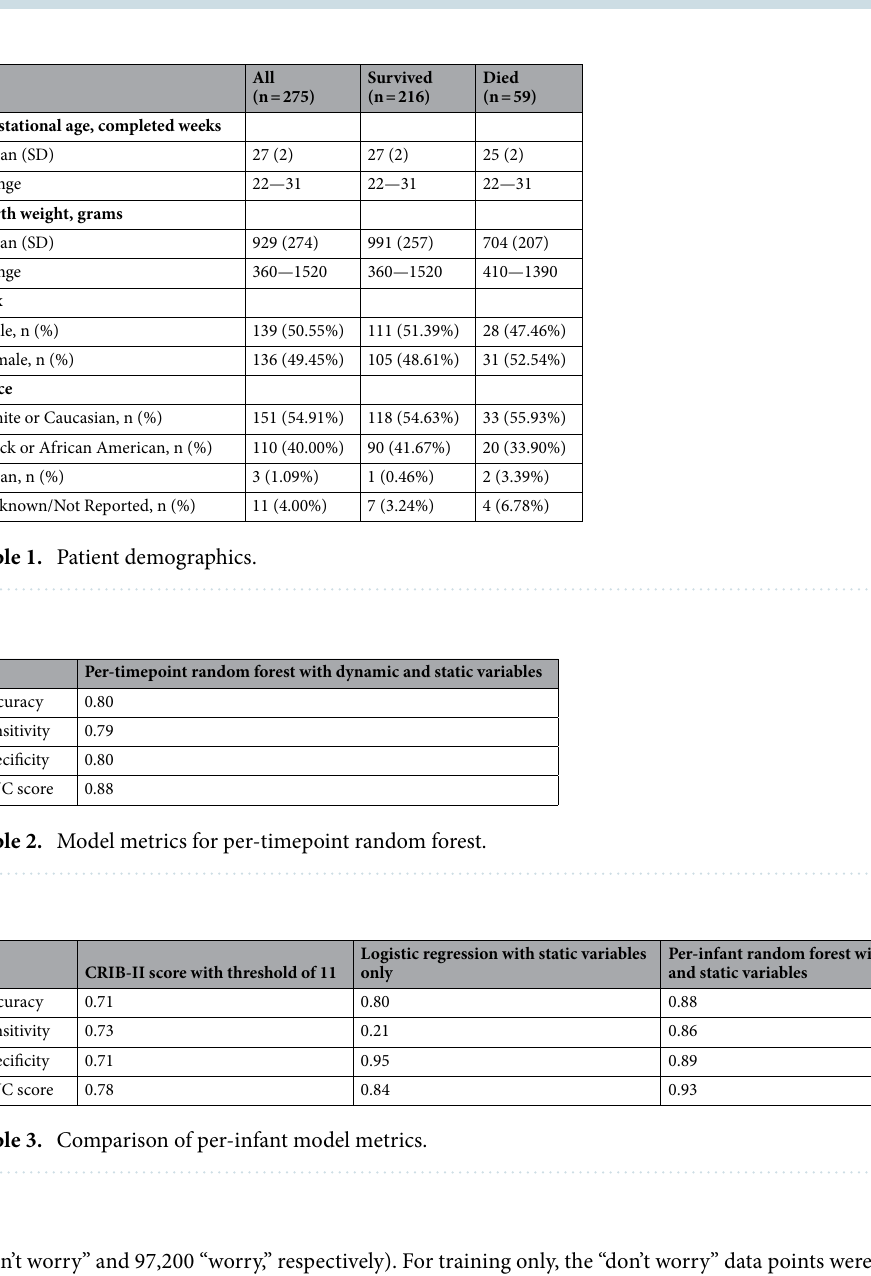
Table 3. Comparison of per-infant model metrics.